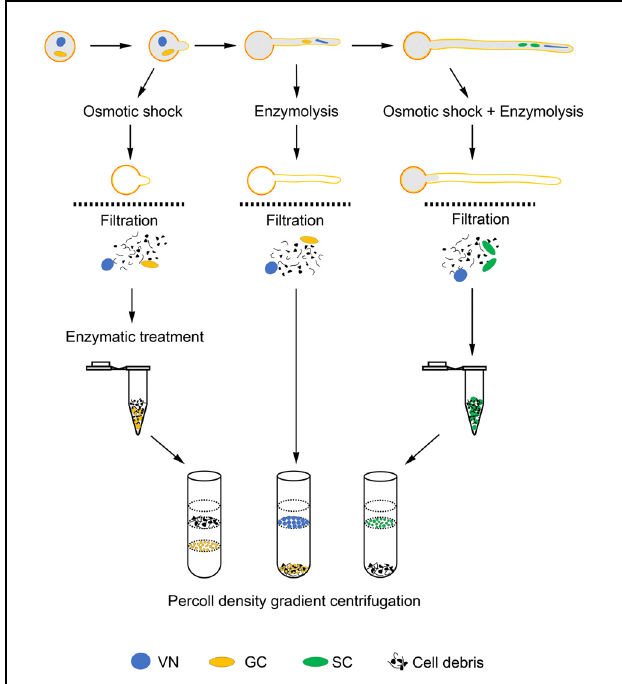
FIGURE 6 | Schematic of methods to isolate GCs, SCs, and